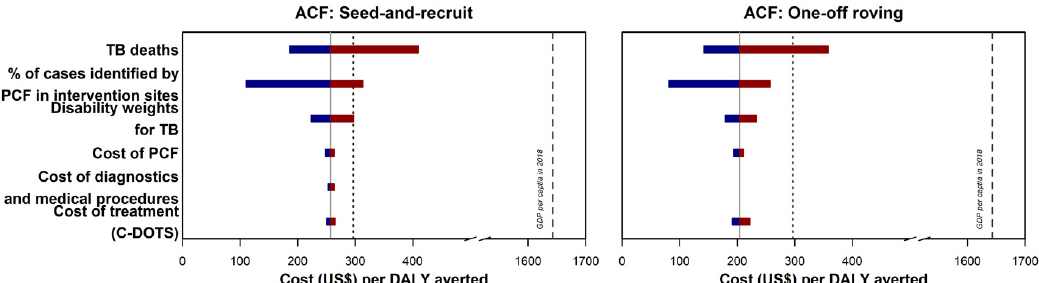
Figure 3. Incremental cost-effectiveness ratio (ICER) tornado plot for multiple one-way sensitivity analyses. TB deaths referred to the estimated TB-related mortality among the undetected cases in the control sites. The percentage of cases identified by PCF in the intervention sites were used to estimate the number of undetected TB cases in the control sites. Disability weights were used in the calculation of years lived with disability and disability-adjusted life years. Cost of PCF referred to the cost used in the primary analysis. Cost of diagnostics and medical procedures referred to the data used to estimate health system cost in the main analysis. The corresponding ICER was not presented for one-off ACF as TB diagnoses were made at the program sites and the costs of the diagnostic were negligible from the health system perspective. Cost of treatment (C-DOTS) referred to the costs estimated from a study by Yadav and colleagues. The grey lines represent the ICER presented in the primary analysis. The cost-effectiveness thresholds—gross domestic product per capita of Cambodia in 2018 and country-specific threshold estimated by Ochalek and colleagues—are presented using black dashed lines and dotted lines, respectively. The maroon section of the bars corresponded to values above the reference ICER, and the blue section of the bars correspond to values below the reference